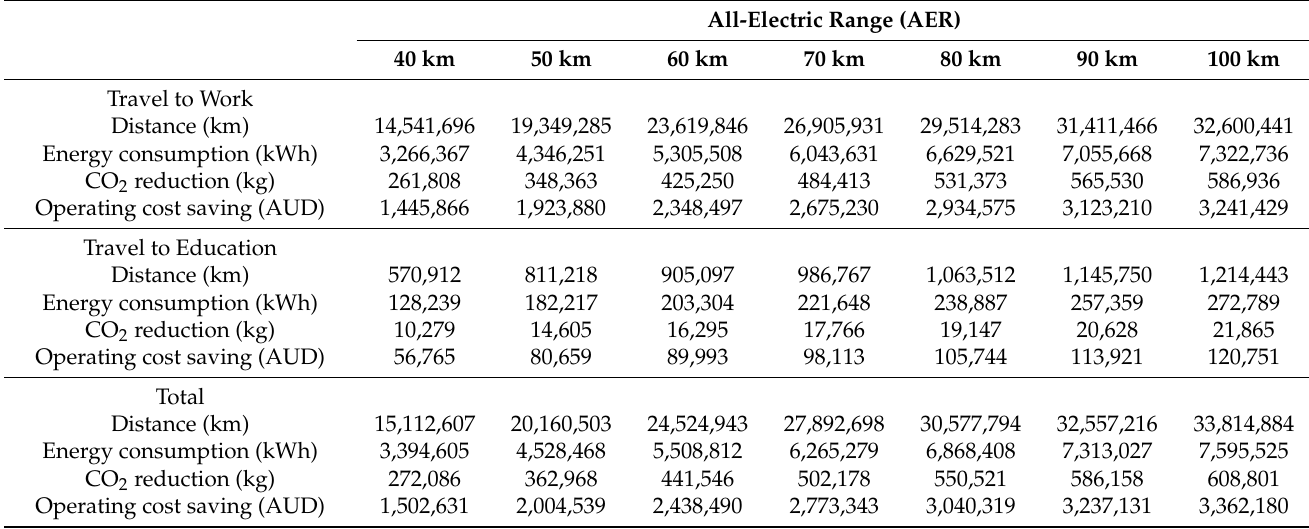
Table 2. Emission, operating cost, and energy impacts of EVs on replacing car travel to work and education (weekday). All-Electric Range